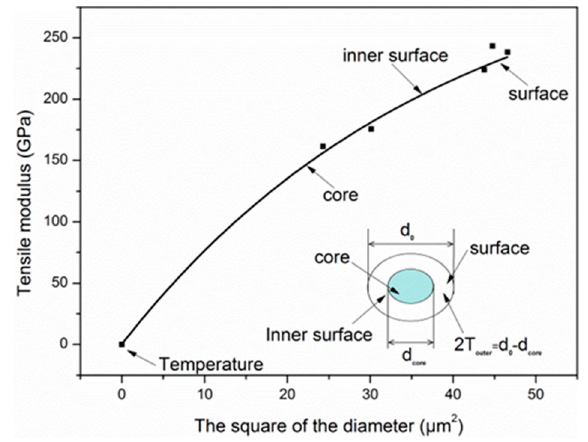
Figure 11. The dependence of the exposure temperature on the radial distribution of tensile modulus of carbon